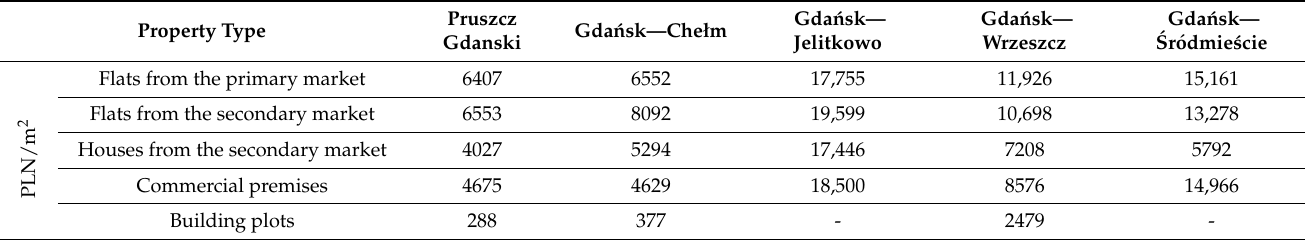
Table 1. Comparison of average real estate prices in Pruszcz Gda´nsk and Gda´nsk. Price per 1 m 2 . (December 2020, 1 PLN = 0.227 EUR, source: own elaboration based on